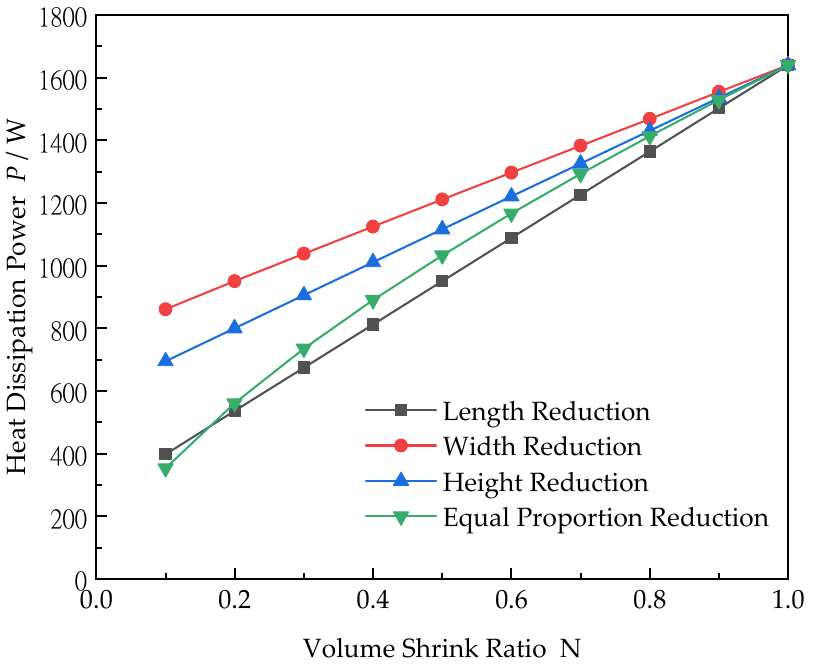
Figure 6. Influence of different reduction methods on heat dissipation power.